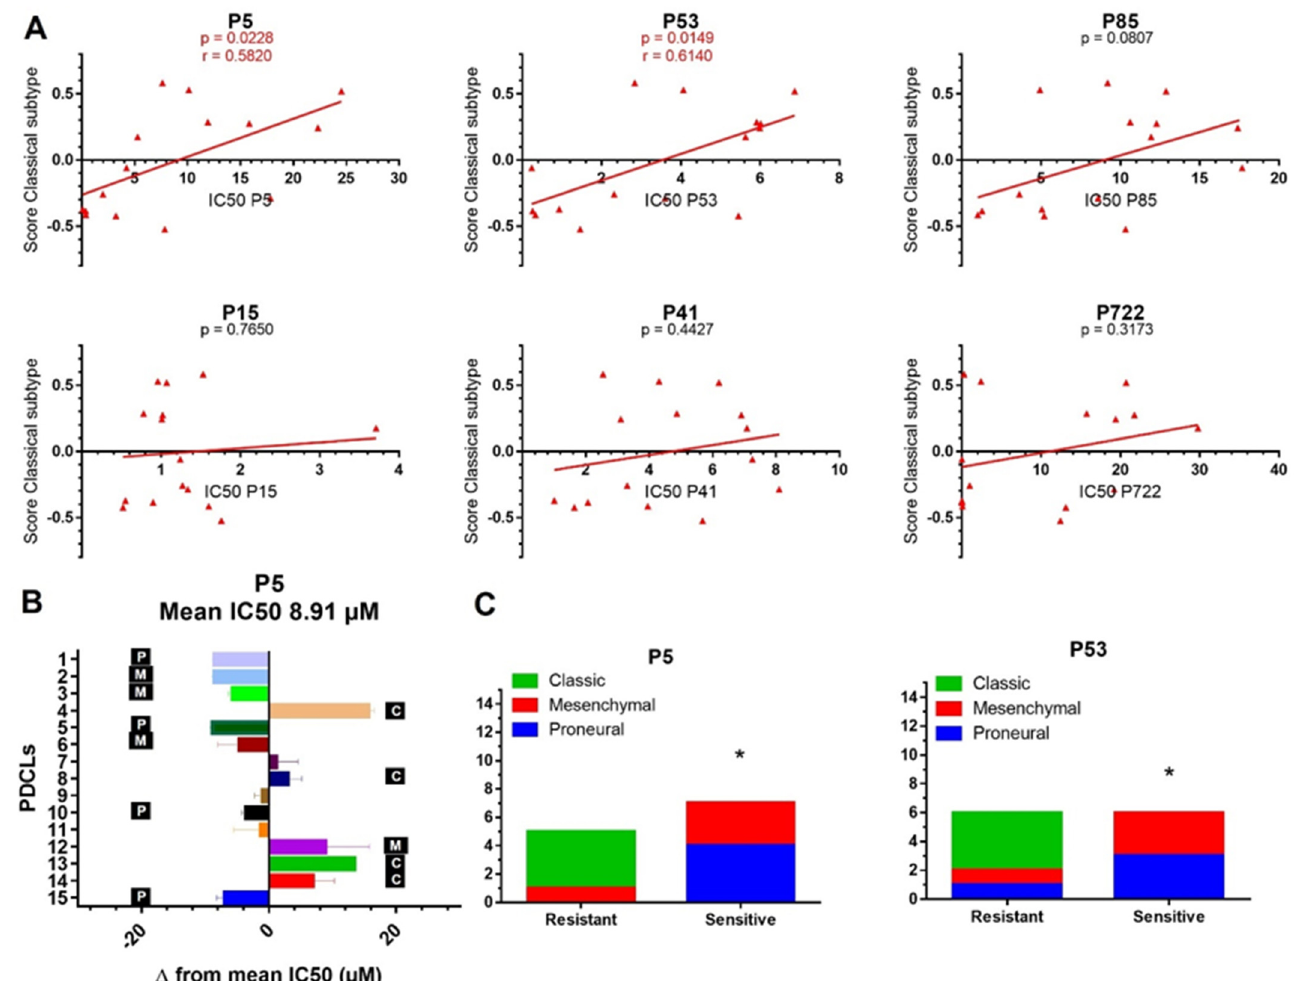
Figure 5. Transcriptomic subgroups predict the response to P5 and P53 . ( A ) Correlations between classical subgroup scores and IC 50 s for each compound. ( B ) For each PDCL, the difference from the mean IC 50 value (8.91 µM) obtained for all PDCLs in response to P5 and their transcriptomic subgroup is shown. C = Classical, P = Proneural, M = Mesenchymal. PDCLs with bars on the right of the median line are considered resistant to P5 while PDCLs with bars on the left are considered sensitive. ( C ) Occurrence of PDCLs from each transcriptomic subgroup in the resistant group and the sensitive group in response to P5 or P53. * p -value ≤ 0.05